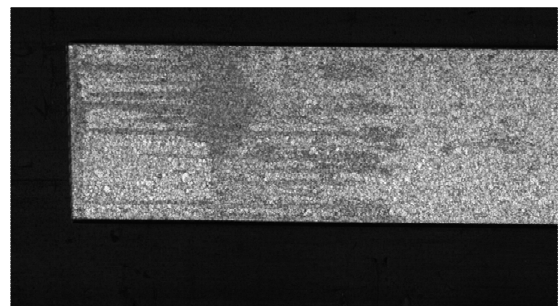
Figure 16. Interference of oil to normal flat tube.